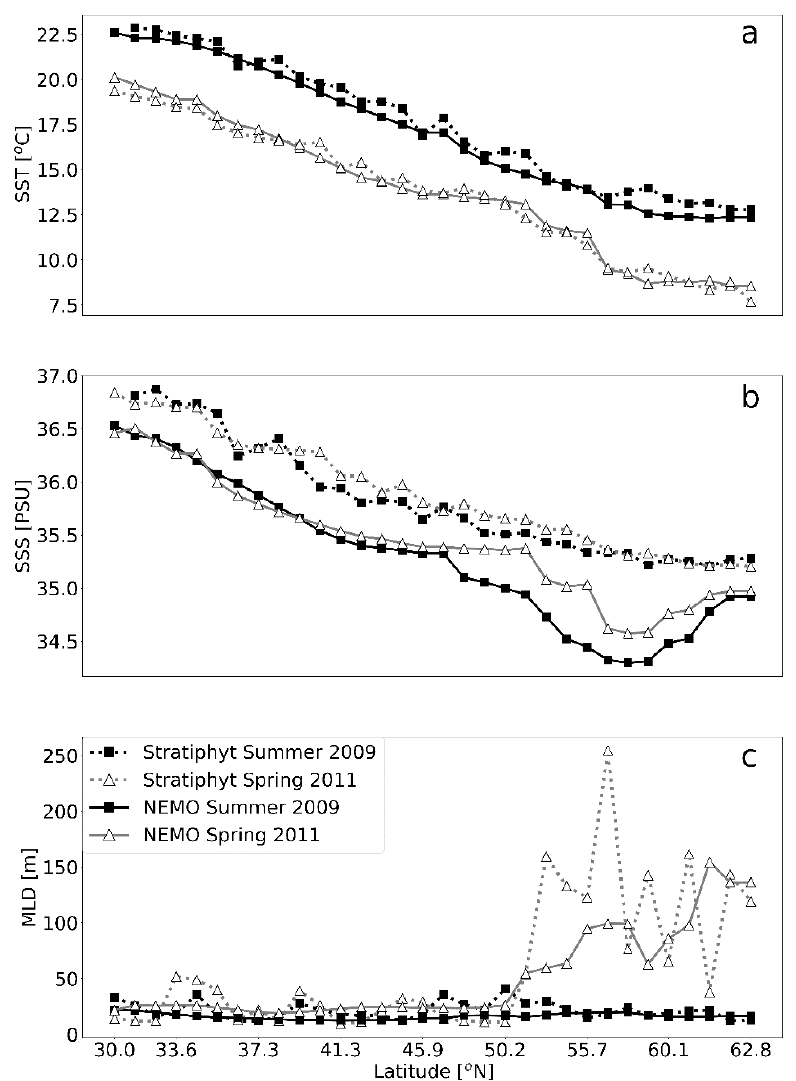
Figure 2. Sea surface temperature (SST) ( a ), sea surface salinity (SSS) ( b ), and mixed layer depth (MLD) ( c ), of Stratiphyt and NEMO (nucleus for European modelling of the ocean) run 1. Model results are April–May (2011) and July–August (2009) averages of stations shown in Figure 1.